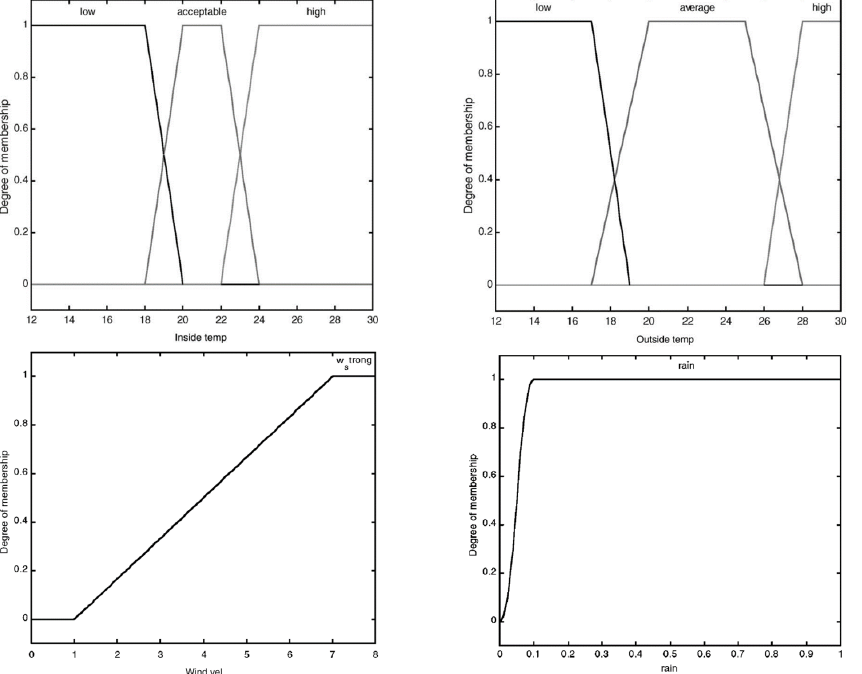
Figure 4. Membership function describing inside temperature ( top left ), outside temperature ( top right ), wind velocity ( bottom left ), and rain ( bottom right ) [57]. right ), wind velocity ( bottom left ), and rain ( bottom right )